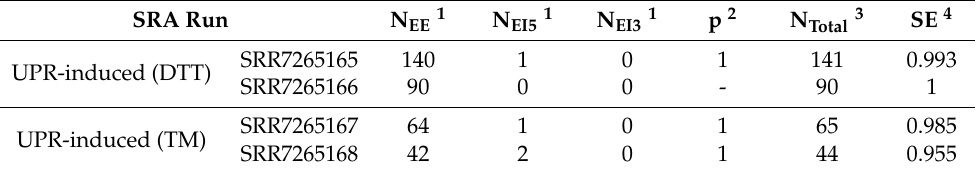
Table 1. HAC1 u is spliced efficiently in unfolded protein response (UPR)-induced cells. The number of RNA-Seq reads mapped to the three splice junctions were quantified by ungapped BLAST in ARSDA. BLAST databases were made for RNA-Seq datasets from WT yeast cells expressed under DTT-induced UPR (SRR7265165, 66) and TM-induced UPR (SRR7265167, 8) conditions. SRA Run N EE 1 N EI5 1 N EI3 1 p 2 N Total 3 SE 4 SRR7265165 140 1 0 1 141 0.993 UPR-induced (DTT) SRR7265166 0 0 - 1 UPR-induced (TM) (cid:48) end exon–intron, and 3 (cid:48) end exon–intron 1 N EE , N EI5 , N EI3 : Number of RNA-Seq reads mapped to exon-exon, 5 junctions, respectively. 2 p: Proportion used to correct bias in N Total , equal to p = N EI5 /(N EI5 + N EI3 ). 3 N Total : total